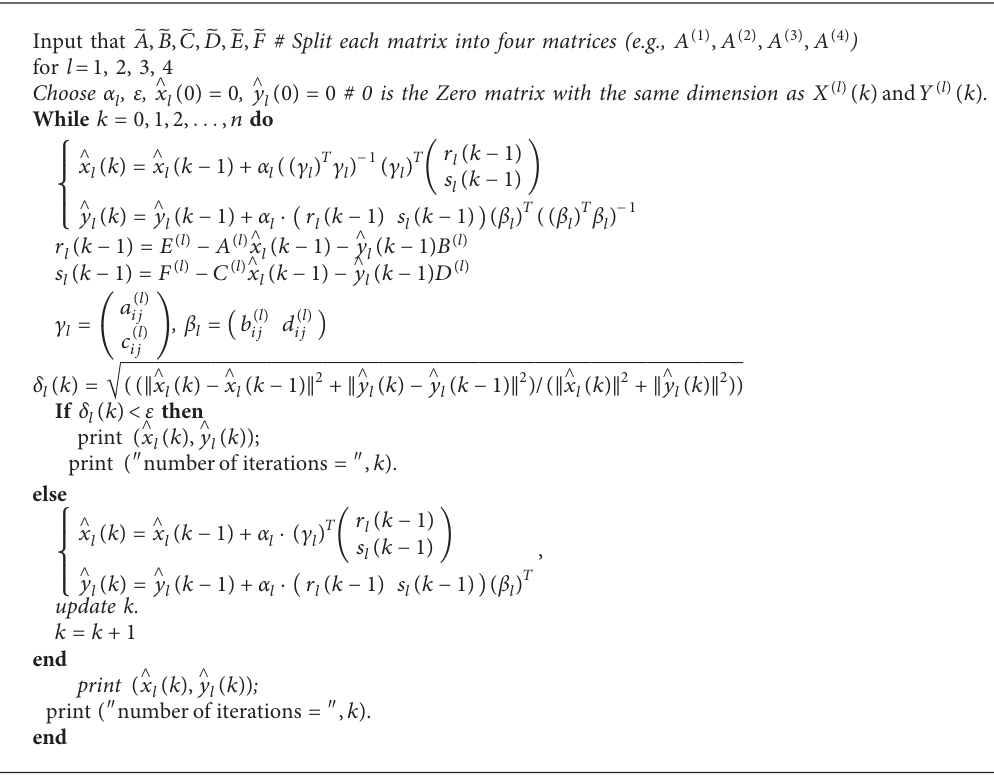
A LGORITHM 3: FLSI algorithm for